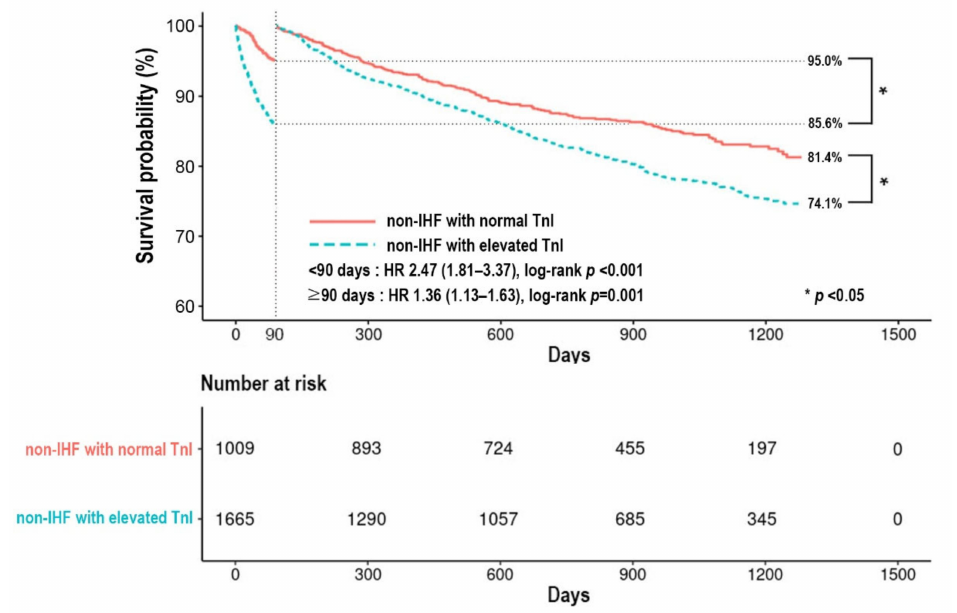
Figure 2. Kaplan–Meier survival curve according to status of TnI in patients with non-IHF. IHF, ischemic heart failure; TnI, high-sensitivity troponin-I; HR, hazard ratio.